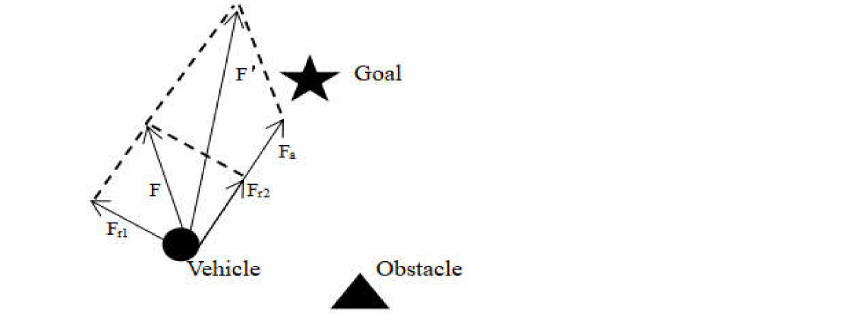
Figure 2. Force analysis of moving vehicle in improved artificial potential field.